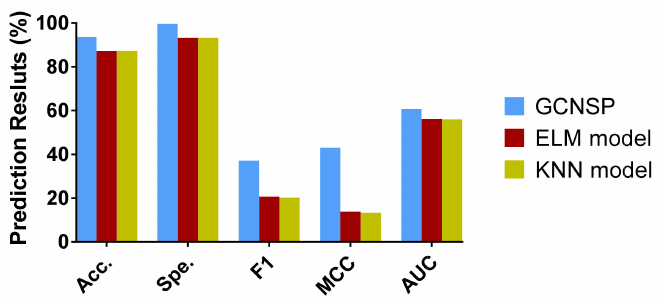
Figure 5. The outcomes of different classifier models in the human data set.